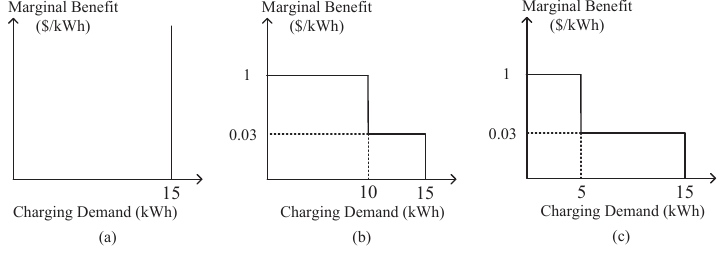
Figure 10. The charging demand curves. ( a ) PEV owner 1; ( b ) PEV owner 2; ( c ) PEV owner 3. Table 3. Comparison of PEV owners’ profits (one day).